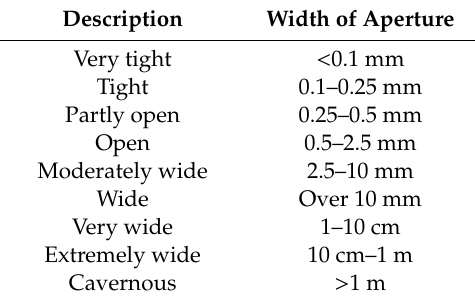
Table 5. Classification of joint aperture